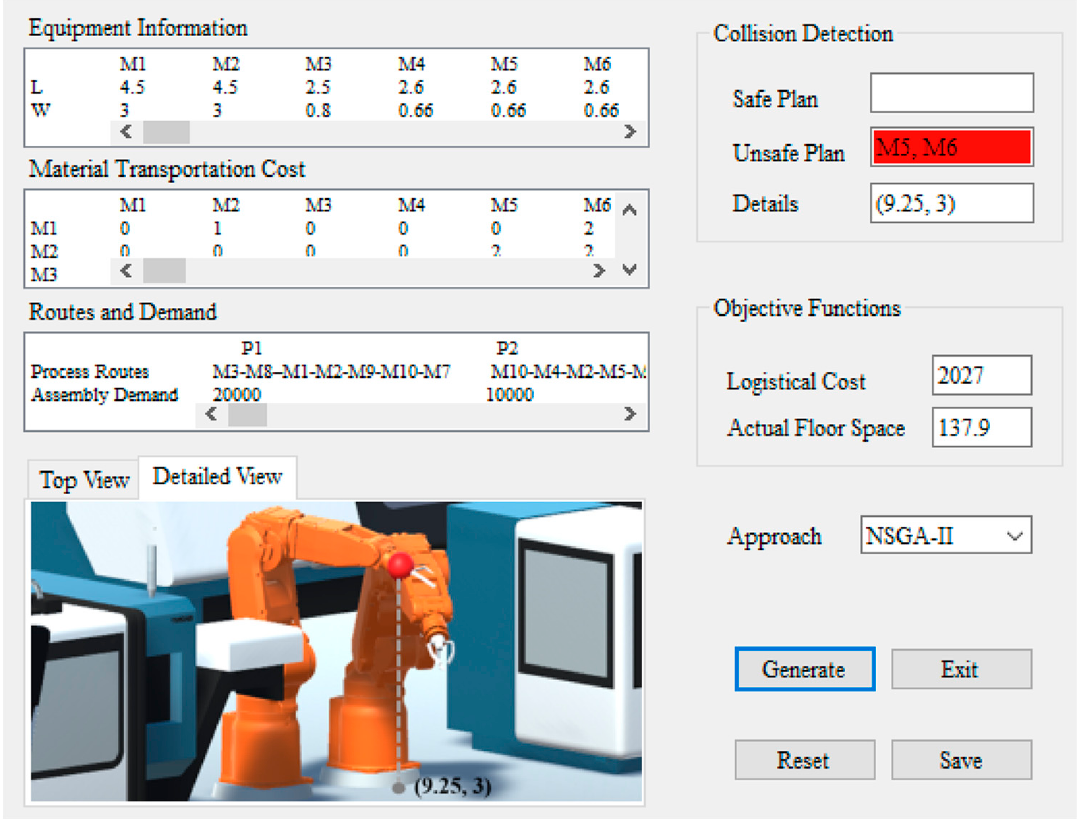
Figure 9. Detailed view of unsafe layout by NSGA-II.